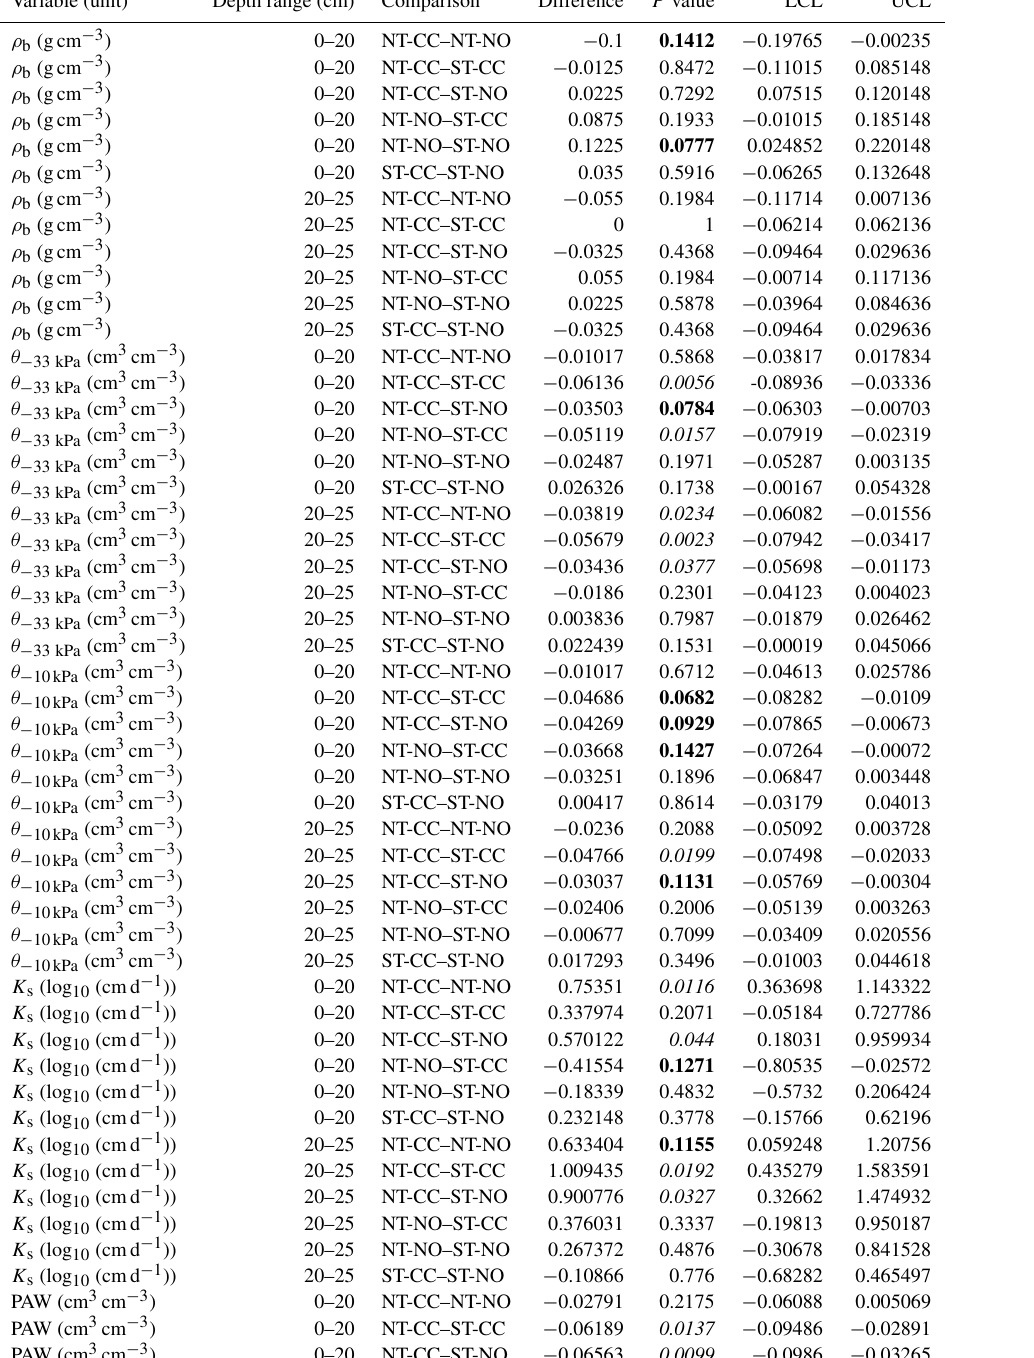
Table B1. Tukey’s HSD test comparison of means for soil hydraulic properties. p values < 0 . 15 are shown using bold font, and p values < 0 . 05 are shown using italic font. LCL and UCL are lower and upper control intervals,